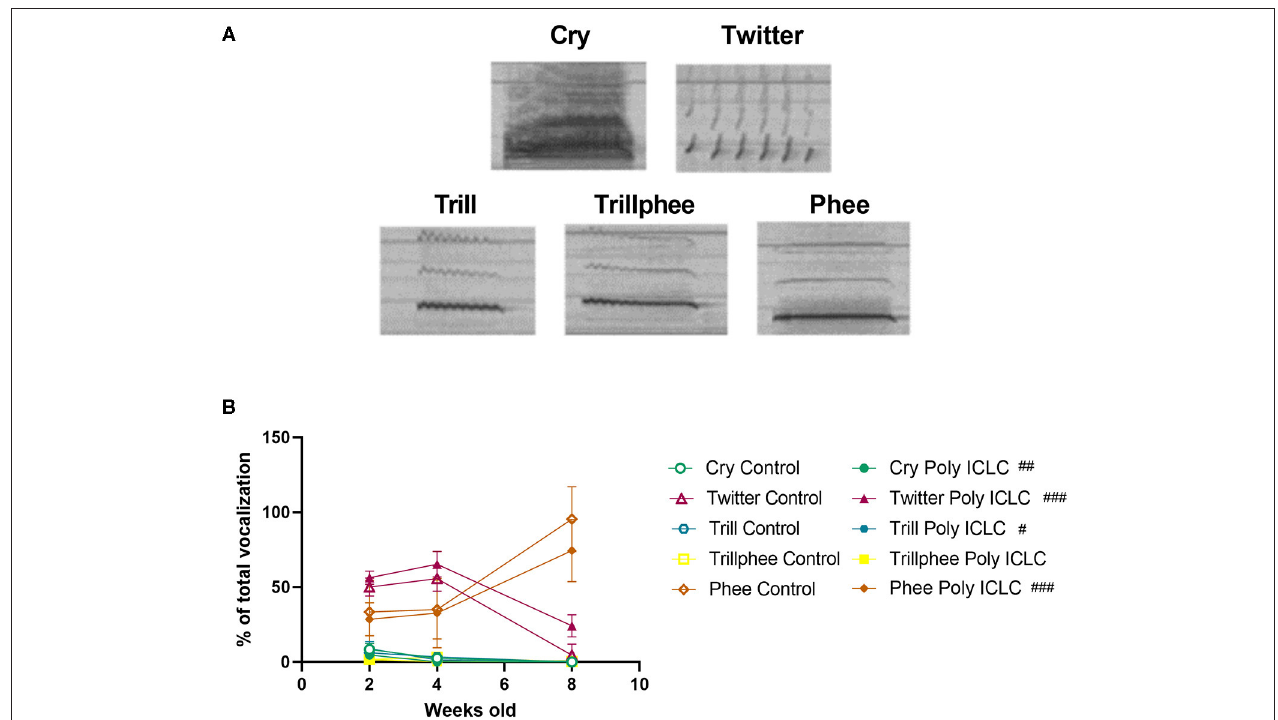
FIGURE 5 | Infants’ repertoire changes during development. (A) Spectrogram of the main calls identified in the vocalization recordings. (B) Proportion of the main calls performed by the offspring throughout development. Data was analyzed by Two-way ANOVA repeated measures with Bonferroni post-hoc . Control n = 8 (6 females and 2 males) and Poly ICLC n = 7 (4 females and 3 males). Data are expressed as mean ± SEM. Significant age effects are indicated by ## p < 0.01 and ### p <